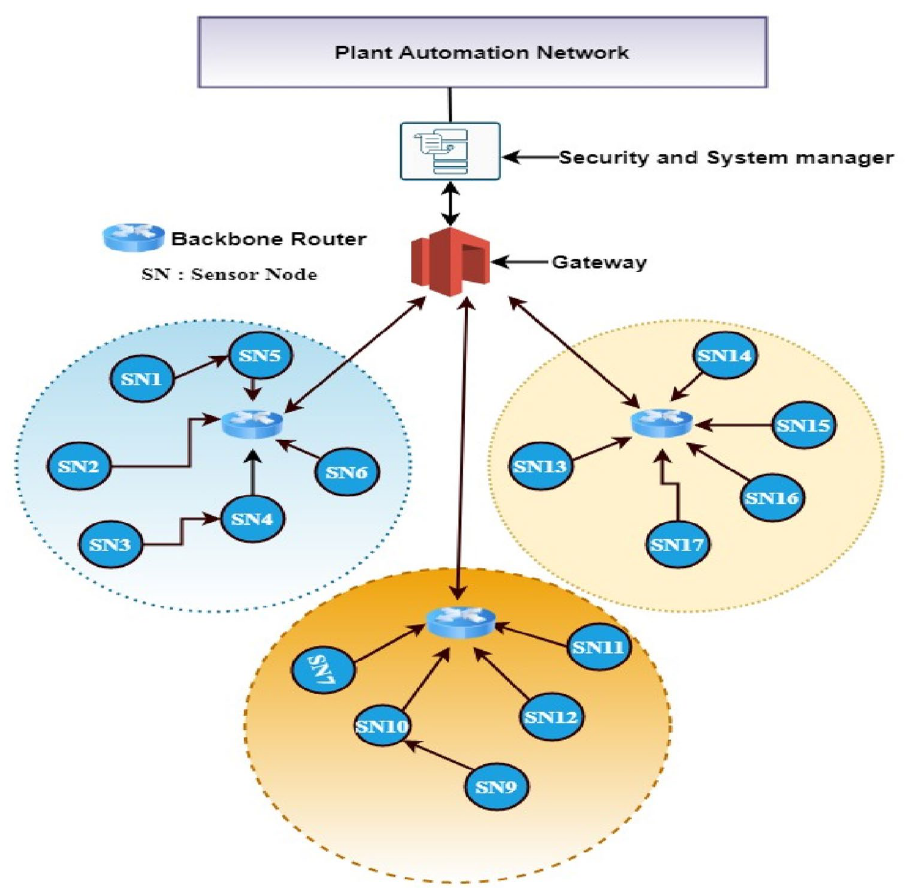
Figure 1. Clustered architecture of industrial sensor